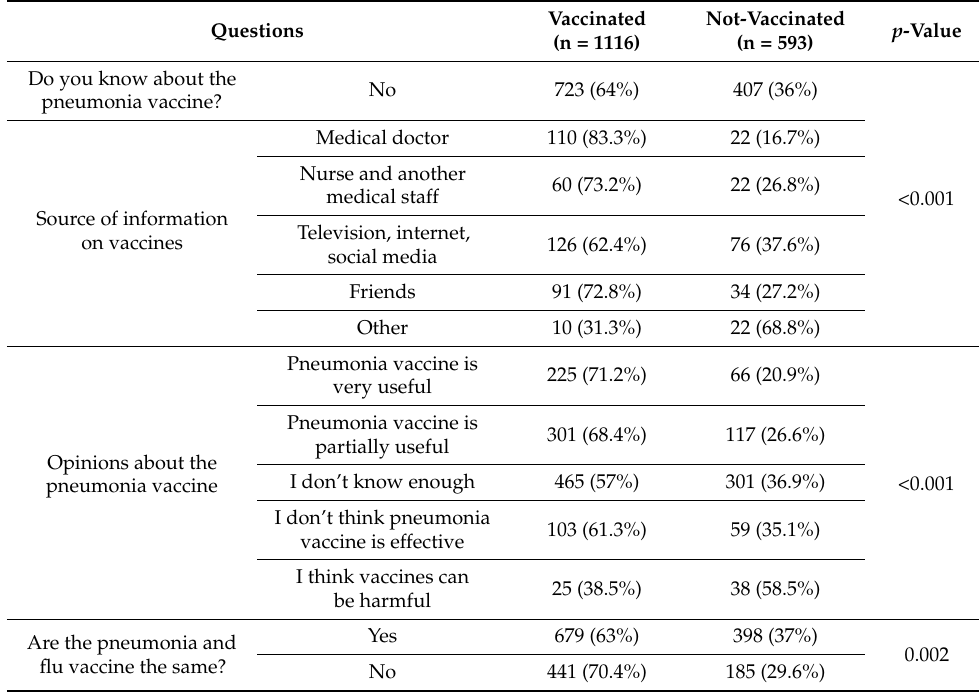
Table 4. Comparison of knowledge and attitudes about vaccination between vaccinated and unvacci- nated patients after being informed about the pneumonia vaccine.